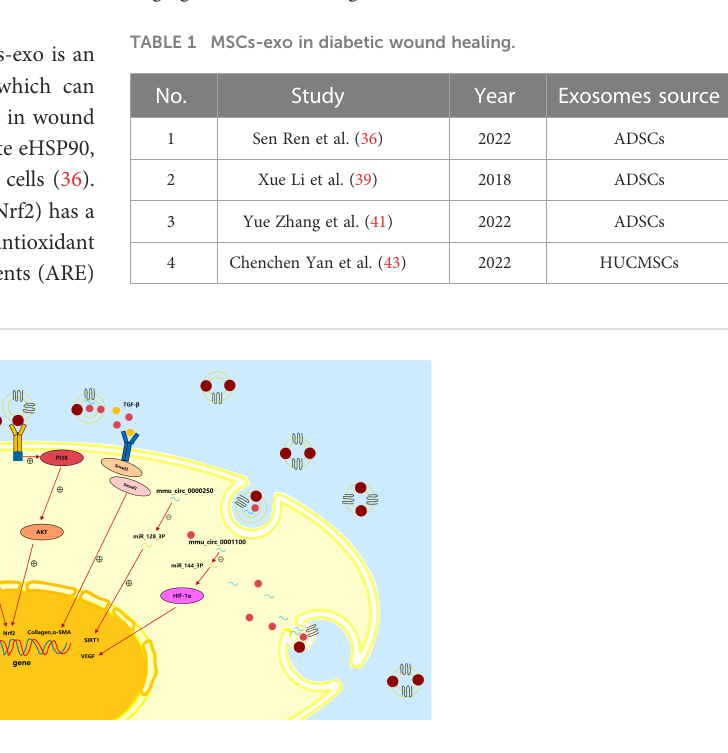
FIGURE 2 The mechanisms of action of the various exosomes in chronic diabetic wound repair.